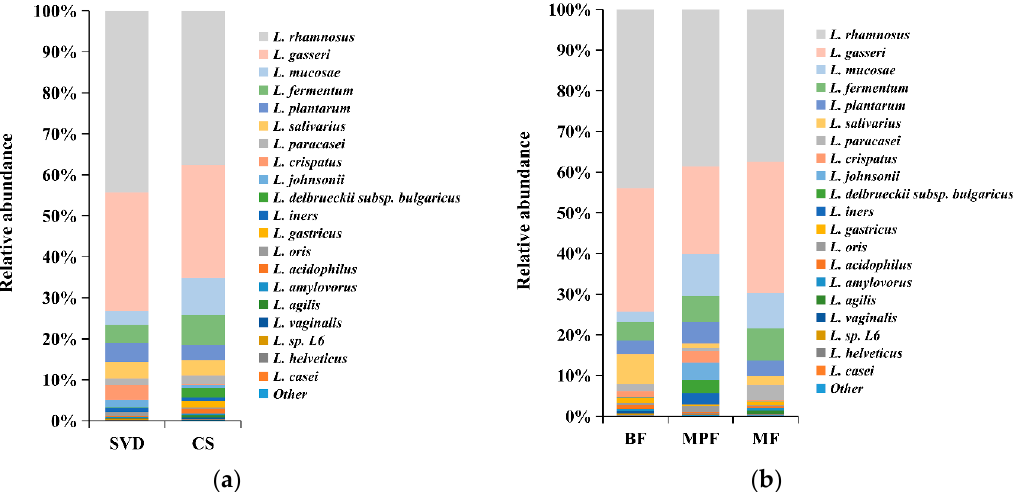
Figure 7. Lactobacillus composition of infant gut in different delivery modes and feeding methods. ( a ) Delivery modes; ( b ) Feeding methods. Showing species found at >1% average in the total population. Species found at <1% were grouped as “other”.